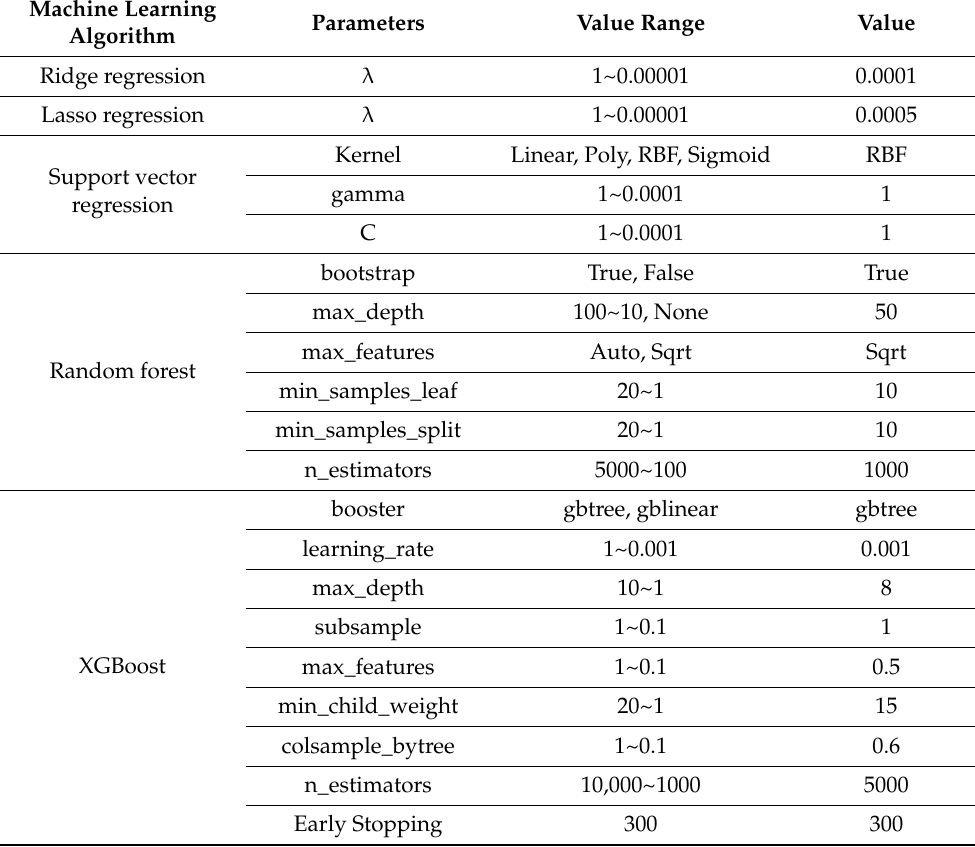
Table 3. Parameter values of machine learning